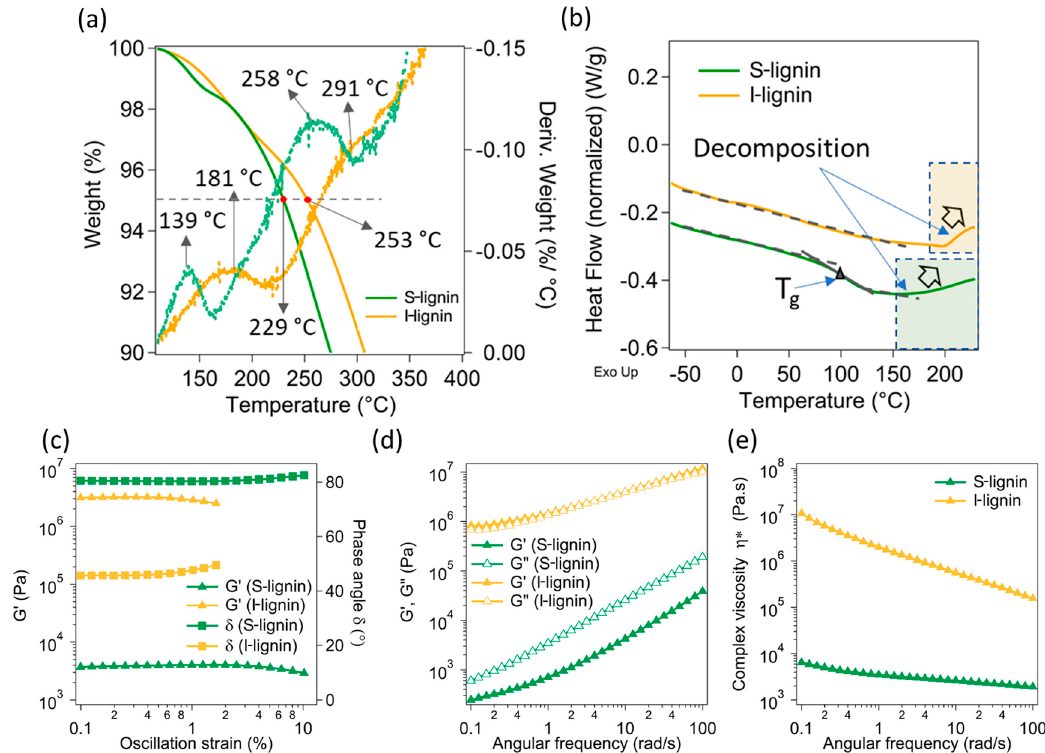
Figure 3. Thermal and rheological characteristics of S-lignin and I-lignin: ( a ) TGA: the solid lines are the weight loss as a function of temperature, the dotted lines are the derivative weight loss; ( b ) DSC; ( c ) Storage modulus (G’) and phase angle (as a function of oscillatory strain; ( d ) Angular frequency dependent storage modulus (G’) and loss modulus (G”); and ( e ) Angular frequency dependent complex viscosity of the studied samples.